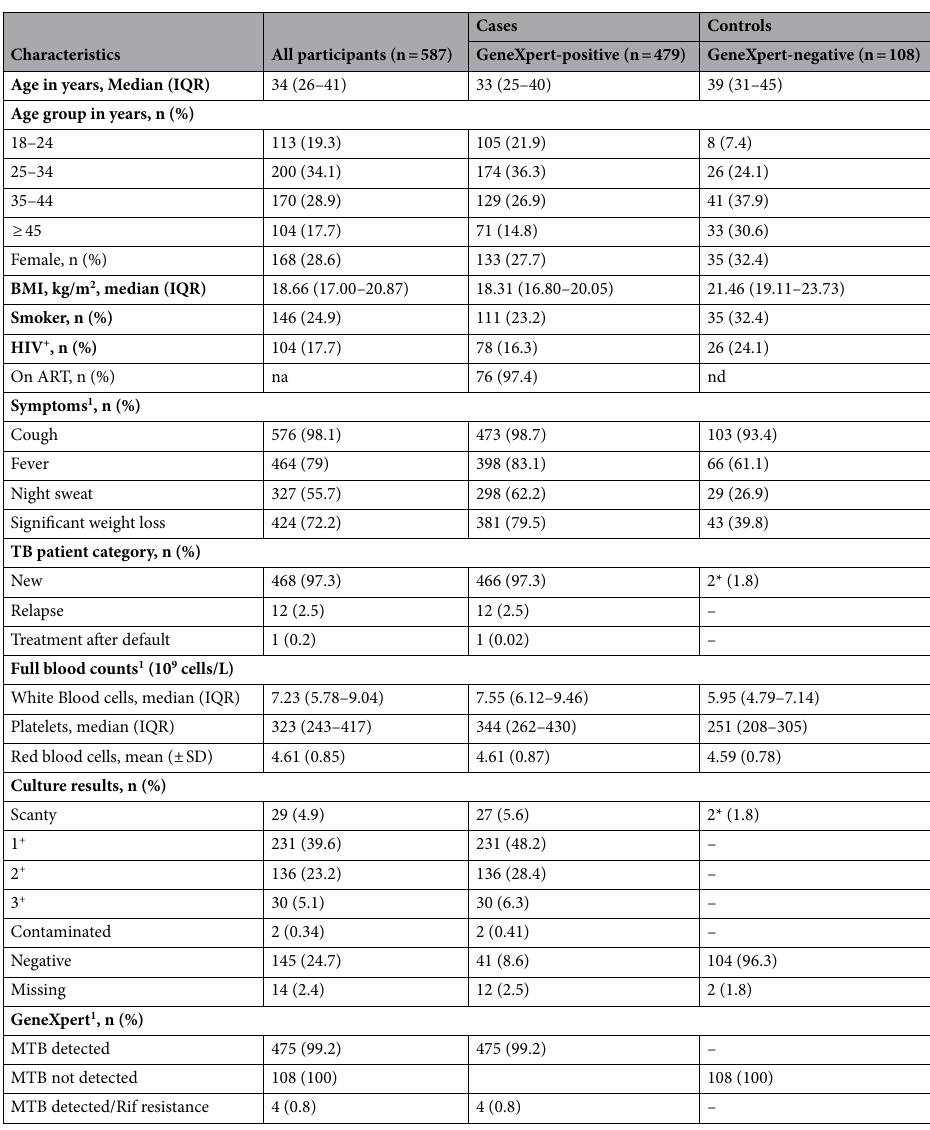
Table 1. Demographics and clinical characteristics of study participants stratified by GeneXpert. BMI-Body mass index, Culture results; Scanty: < 20 colonies, 1 + : 20 to 200 colonies, 2 + : > 200 discrete colonies, 3 + : > 200 confluent colonies. * Recruited as controls but included as cases, MTB: M. tuberculosis , RIF: Rifampicin, ART: Antiretroviral therapy; 1 Symptoms/condition at enrolment, na: not applicable, nd: no